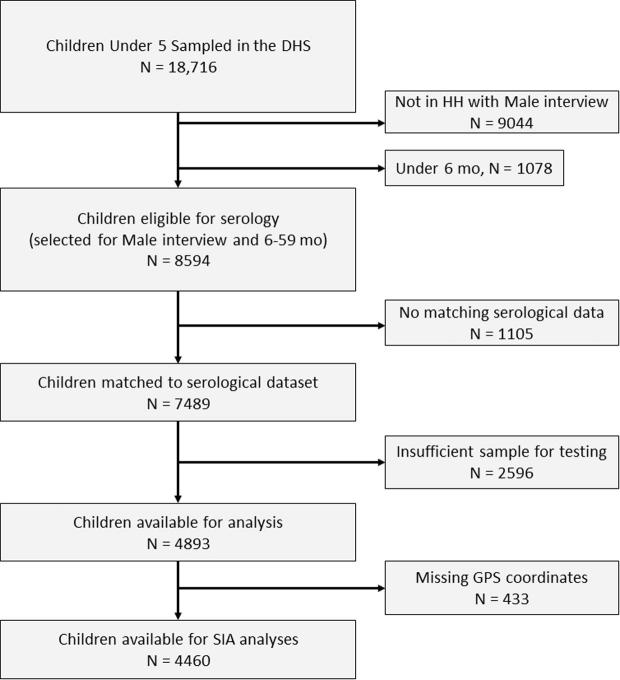
Sample size resulting from applying inclusion criteria and removing missing data.